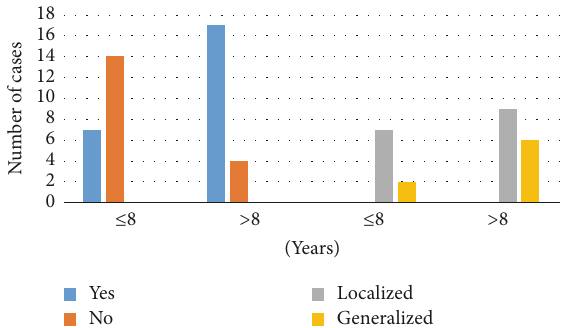
Figure 2: Number of cases and type of periodontal disease.